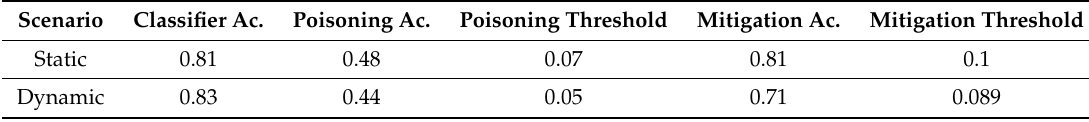
Table 3. Adversarial Attacks and Mitigation